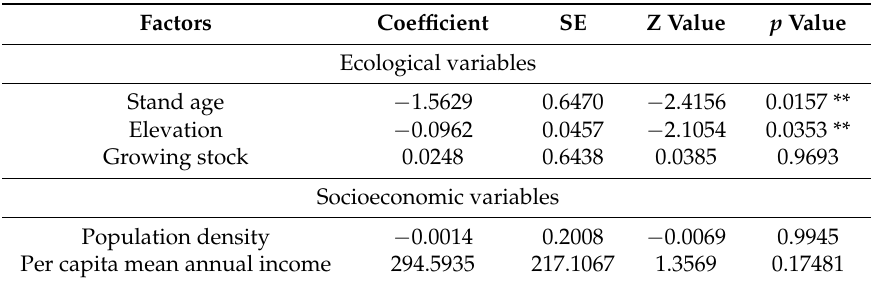
Table 4. Empirical results of major factors affecting the abundance of invasive trees at the county level on Mississippi forestlands based on the spatial lag